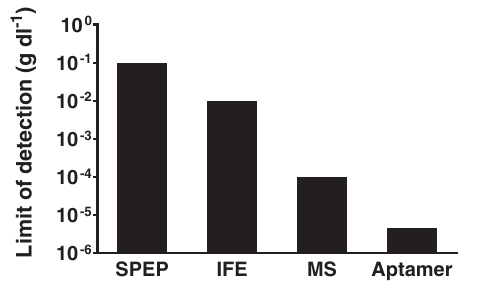
Fig. 5 Comparison of sensitivity of serum-based approaches to measure M-Ig. The LoD of M-Ig speci fi c high-af fi nity aptamers are 2000-fold more sensitive than